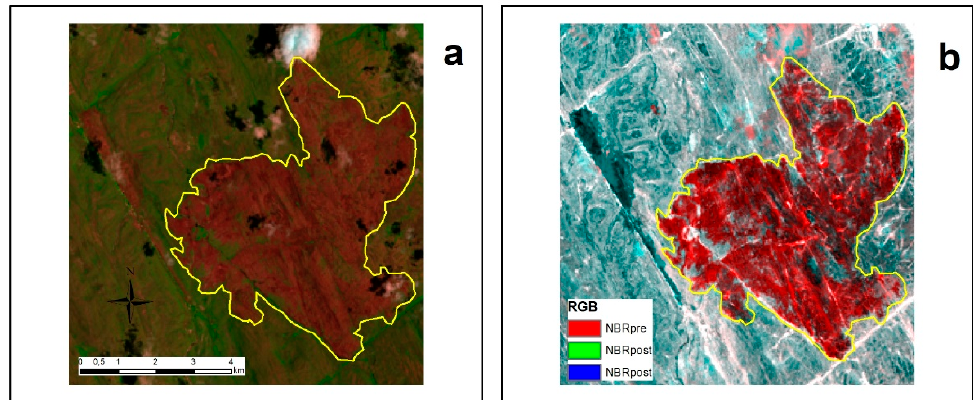
Figure 8. Pictures of: ( a ) colored composition image corresponding to the postfire image for the fire near Mucugê, data from the Landsat-8 7-5-4 RGB OLI sensor. ( b ) multitemporal visualization of the burnt area in the fire near Mucugê, NBRpre/NBRpost/NBRpost RGB.